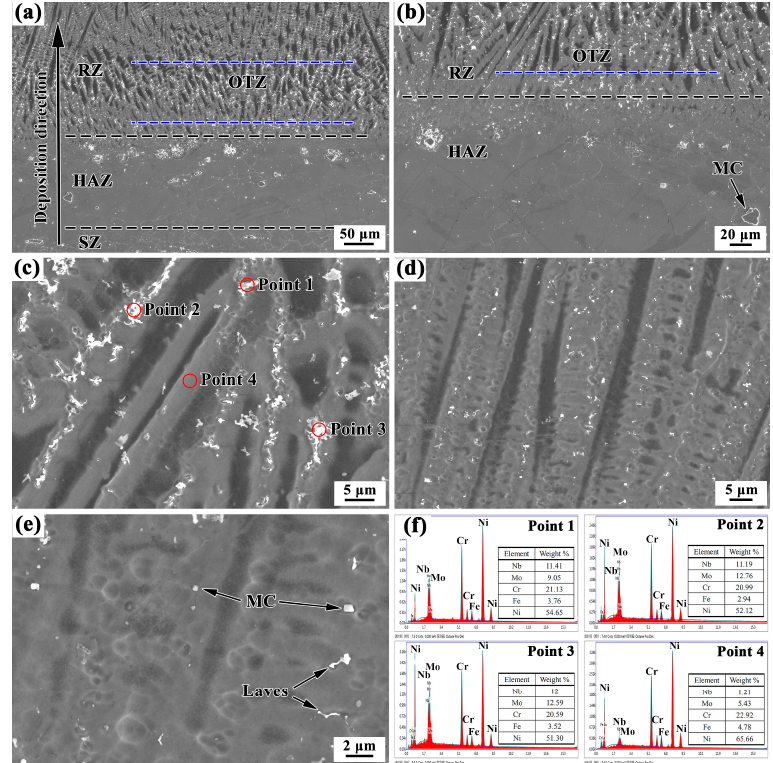
Figure 9. Microstructures of LARed samples in different zones: ( a ) SZ+heat-affected zone (HAZ)+RZ, ( b ) HAZ+RZ, ( c ) overlapping transition zone (OTZ), ( d , e ) RZ, and ( f ) EDS taken from laves phase and matrix phase of OTZ around the repaired interface.